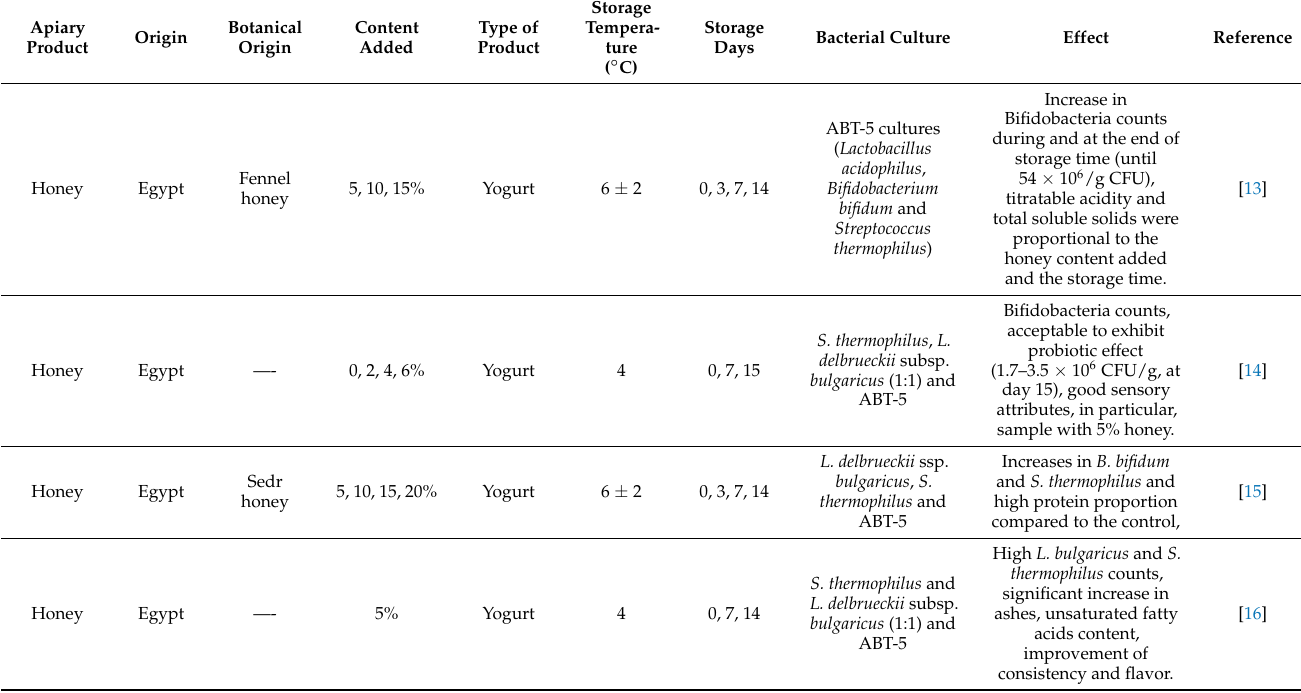
Table 1. Effect of the concentration of bee products in dairy products, on bacterial cultures and physicochemical properties. Apiary